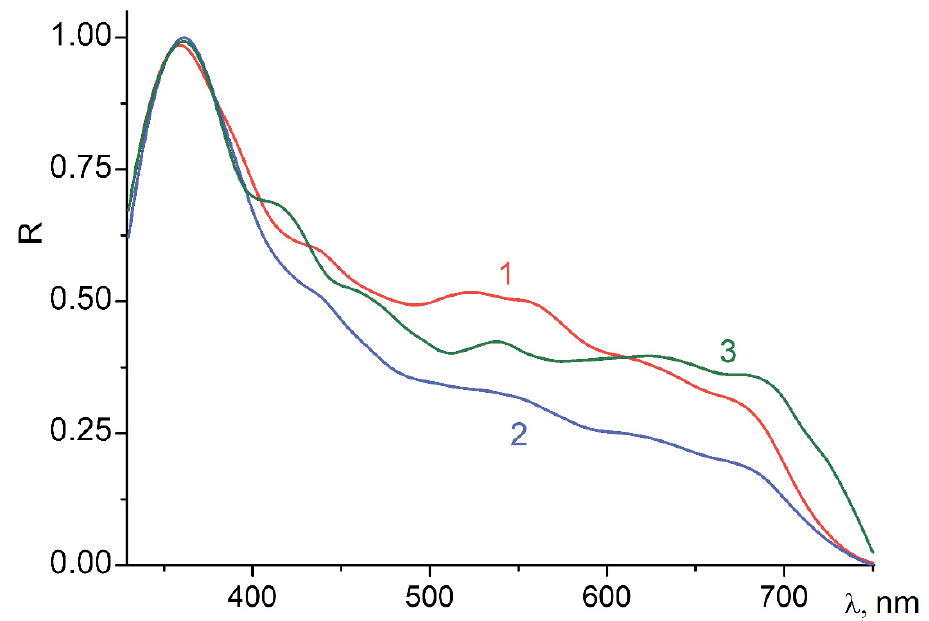
Figure 2. Normalized Spectra of Diffuse Reflection of Light from the SW TiO 2 NTs/Cu x O-10 (1), SW TiO 2 NTs/Cu x O-30 (2) and SW TiO 2 NTs/Cu x O-60 (3).